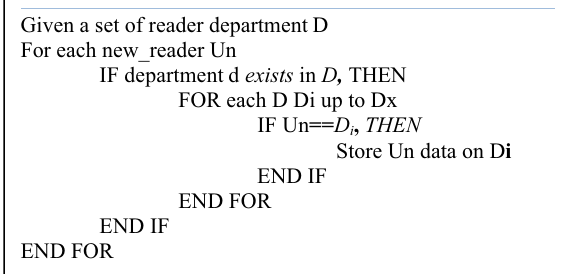
Algorithm 1 Reader Clustering